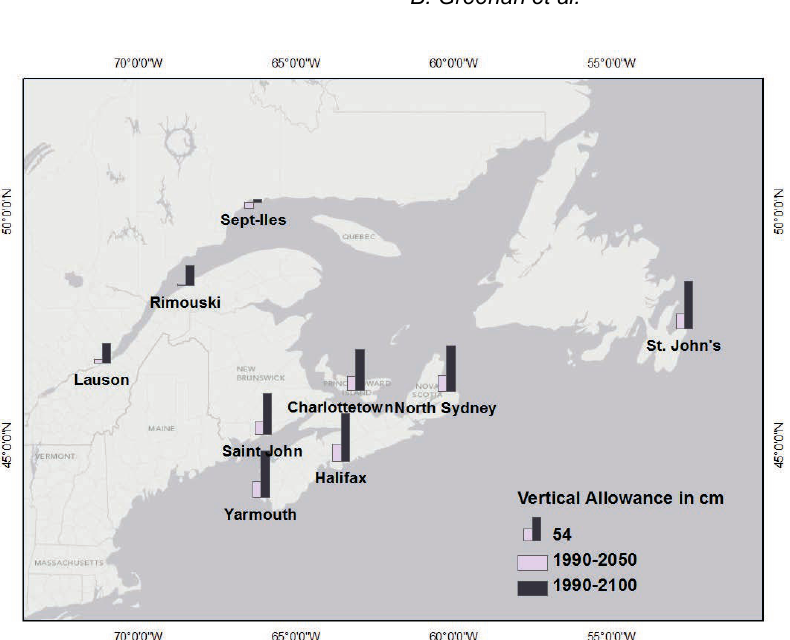
Fig. 1 Map showing representative tide gauge stations in Atlantic Canada. Vertical allowances are shown in white for the period 1990–2050, and in black for the period 1990–2100. The scale of the black vertical bar in the legend is 54